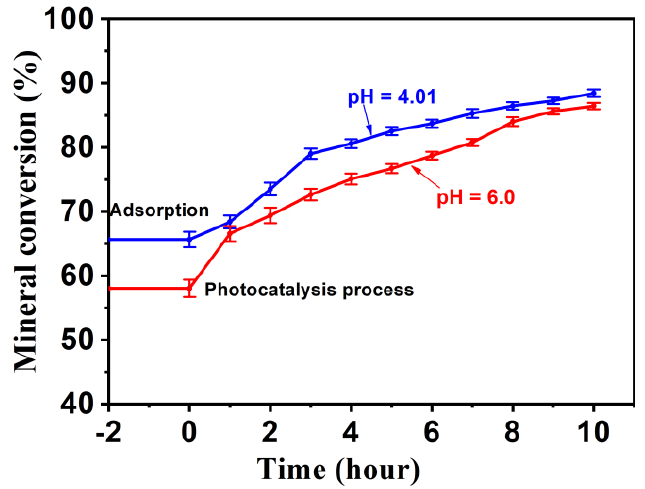
Figure 14. The mineralization conversion of the textile dyeing wastewater after 10 h of irradiation in the presence of CuH–3.5 material.